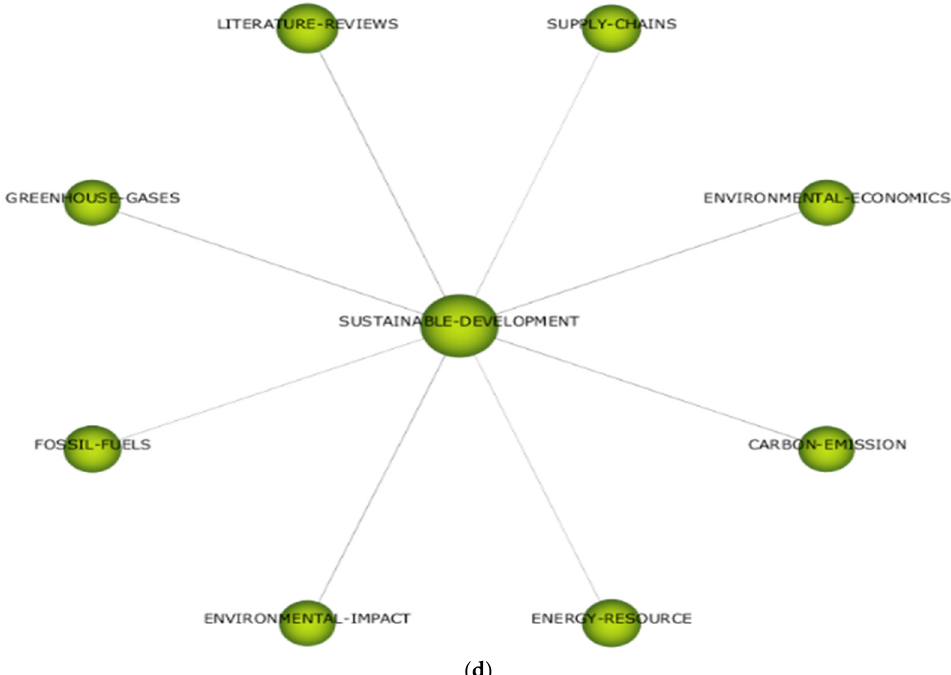
Figure 8. Major theme ( a ) and thematic network ( b – d ) of the fourth sub-period (2016–2020). Note: Clusters information: GASES (centrality: 39.98; density: 24.38); INVESTMENTS (centrality: 14.86; density: 5.02); SUSTAINABLE-DEVELOPMENT (centrality: 7.54; density: 5.12); RISK (centrality: 4.73; density: 11.38); CRITICAL-INFRASTRUCTURES (centrality: 0.49; density: 25); DEVELOPING-COUNTRIES (centrality: 6.19; density: 9.07); CREDIT-RISK (centrality: 0; density: 33.33); DECI-SION-TREES (centrality: 0.2; density: 33.33); CATCHMENTS (centrality: 0.13; density: 25); INFRA-STRUCTURE-PROJECT (centrality: 0.61; density: 25); BAYESIAN-NETWORKS (centrality: 0.41; density: 20); HEALTH-RISKS (centrality: 0.49; density: 8); ACCIDENTS (centrality: 6.01; density: 6.25). Node size is proportional to the number of papers; the number in a node denotes the number of papers related to a node topic. See Section 2.2 for description of the quadrants. Table 7. Cluster information and key parameters—sub-period (2016–2020). Core Documents Internal Links Cluster Centrality Density Count H Index Average Citations Node Weight